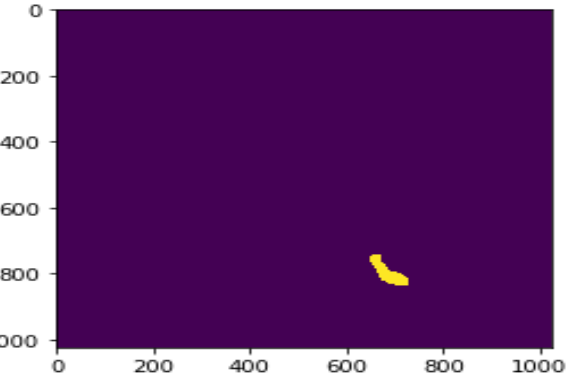
Figure 12. Mask generated for the reference image ID (The yellow color area indicates the mask).